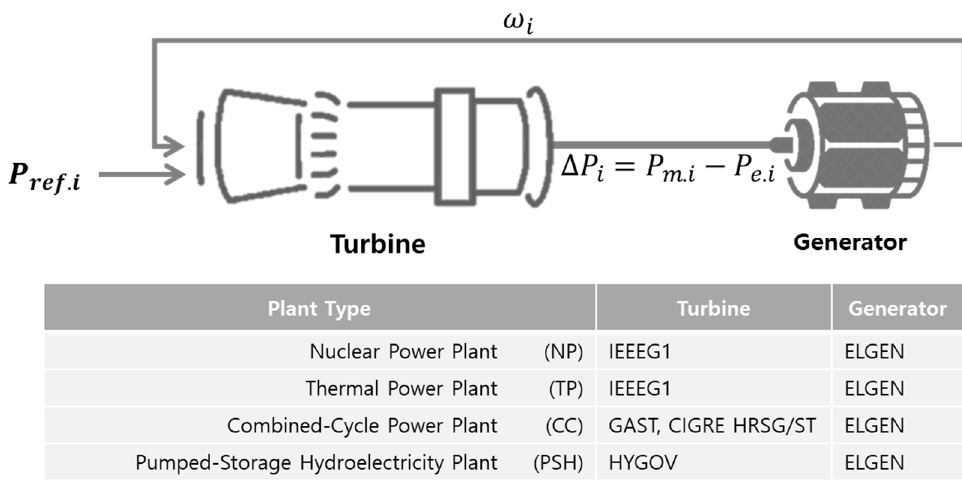
Figure 2. Configuration of CPP model and detail module about turbine and generator.